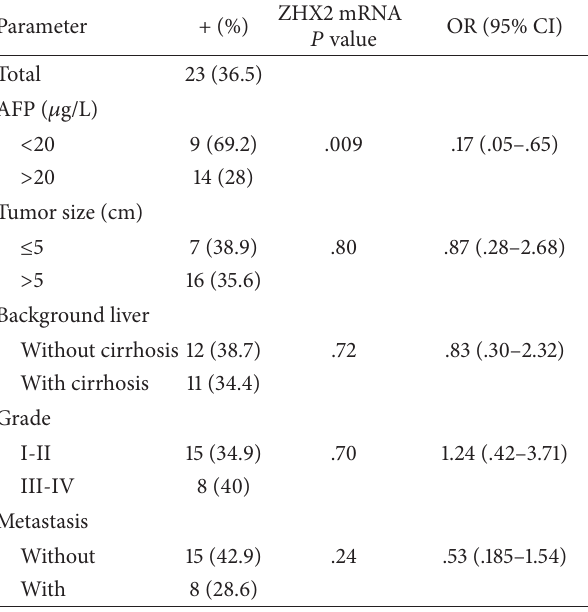
Table 2: Relationship between ZHX2 mRNA expression and clini- copathological parameters in HCC